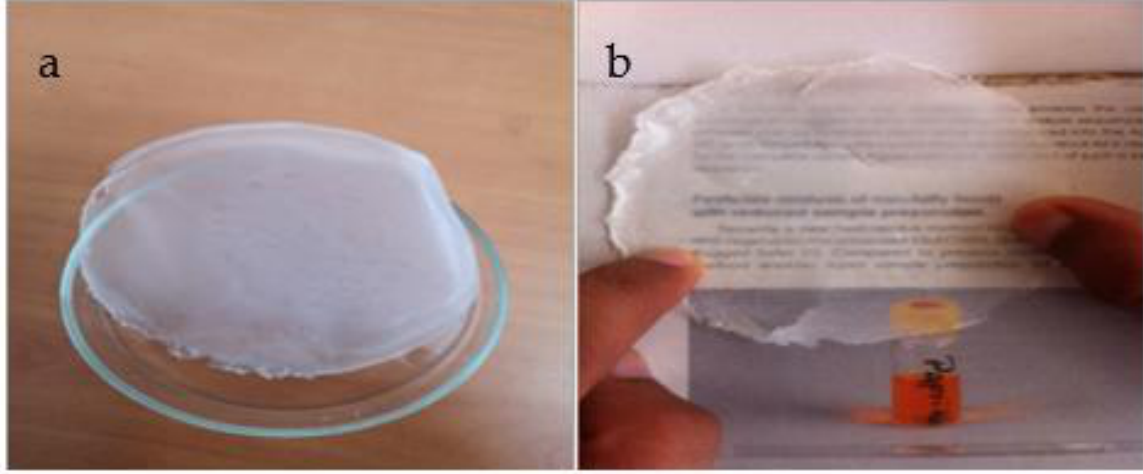
Figure 3. Image of the HAp/HPMC membrane. ( a ) thin and homogenous film and ( b ) transparent film. The FT-IR spectra of HAp, HPMC and a composite of 30 wt.% HAp and 70 wt.% HPMC are overlaid in Figure 4. The spectrum of HPMC shows a band at about 3460 cm − 1 corresponding to the stretching vibrations of the O-H bond. The Infrared spectrum also shows a band at 2800 cm − 1 due to the stretching vibration of C-H bonds concerning the methyl and hydroxypropyl groups of HPMC. The band at 1643 cm − 1 corresponds to the vibrations of the cyclic C-O bond [70]. The band at 1093 cm − 1 corresponds to the elongation vibration of the glycosidic linkage C-O-C